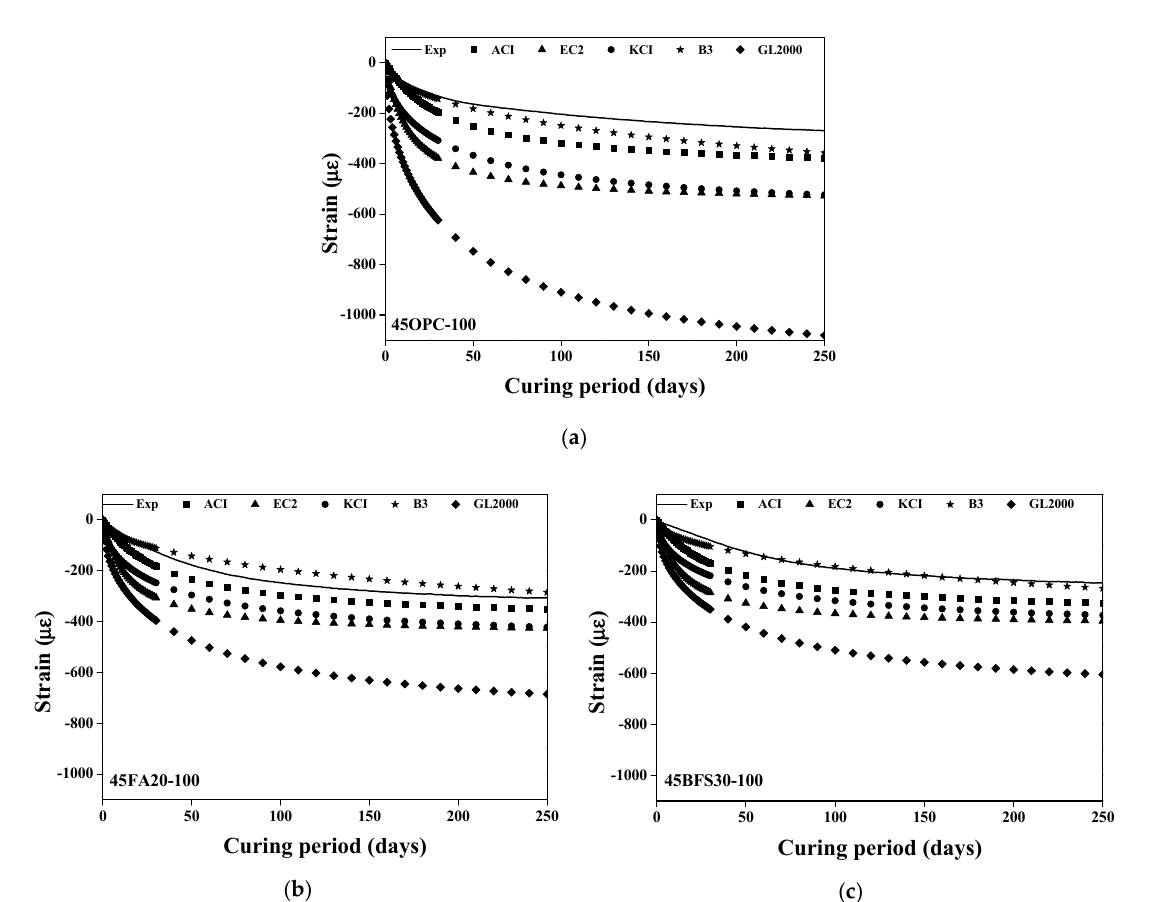
Figure 10. Comparison between test results and predicted value (steel slag substitution ratio: 100%).